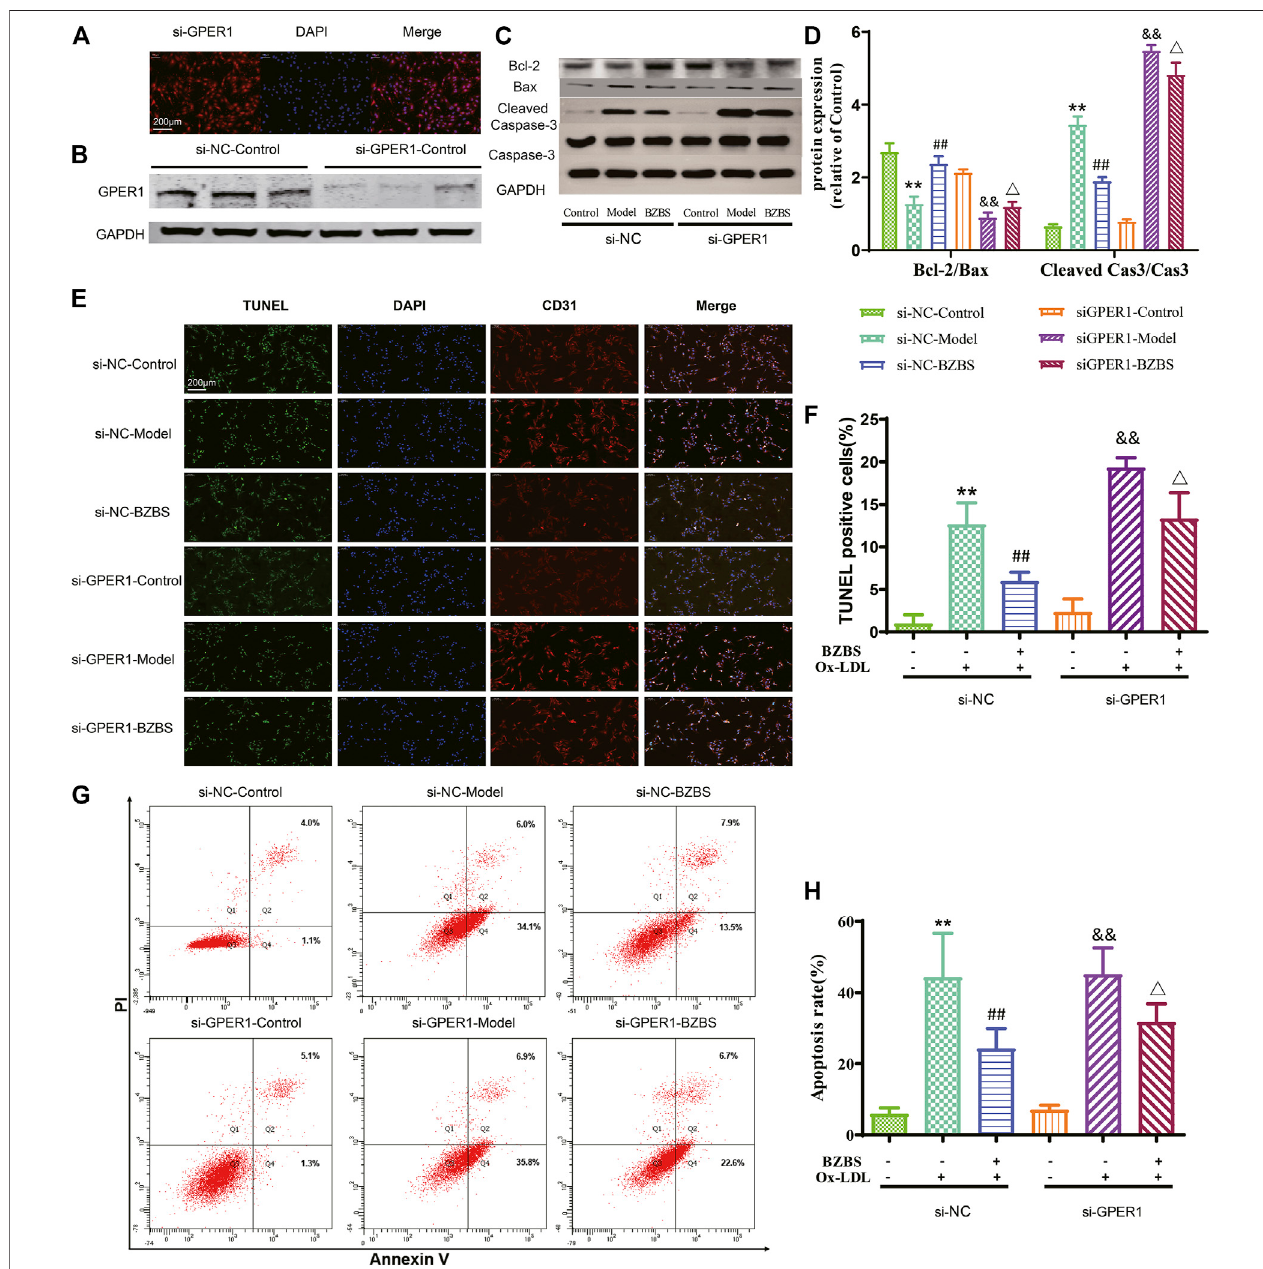
FIGURE 4 | Effect of BZBS on the apoptosis of Ox-LDL-induced HUVECs with GPER1 de fi ciency. (A,B) GPER1 protein levels were measured 40 h posttransfection to evaluate knockdown ef fi ciency. (C,D) Western blots showing Bcl2, Bax, and caspase-3 proteins. (E,F) Annexin V-FITC/propidium iodide (PI) (G,H) was used to measure the apoptotic rates in the various groups of Ox-LDL-treated HUVECs. The data are presented as the mean ± SD. ** p < 0.01 vs. the si-NC control group; ## p < 0.01 vs. the si-NC model group; && p < 0.01 vs. the si-GPER1 control group; △ p < 0.05 vs. the si-GPER1 model group ( n (cid:1) 3).